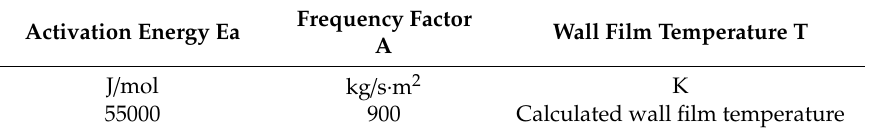
Table 1. Urea pyrolysis kinetic parameters (Kim).